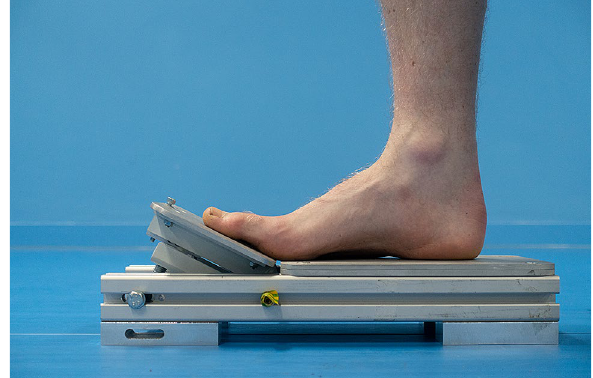
Figure 2. Image showing foot position on the